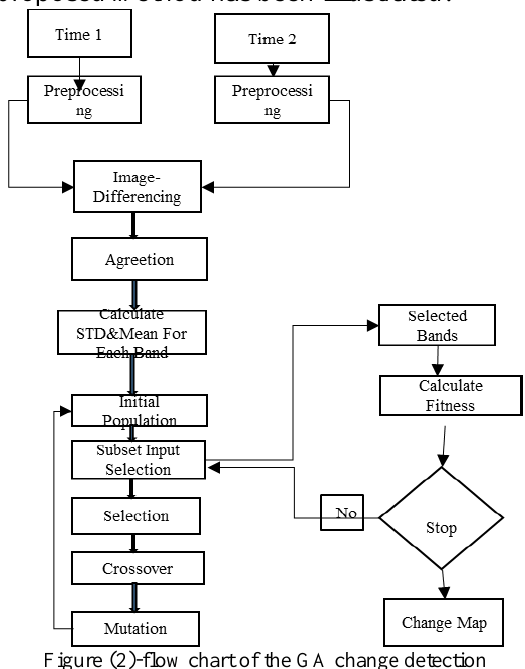
Figure (2)-flow chart of the GA change detection method.